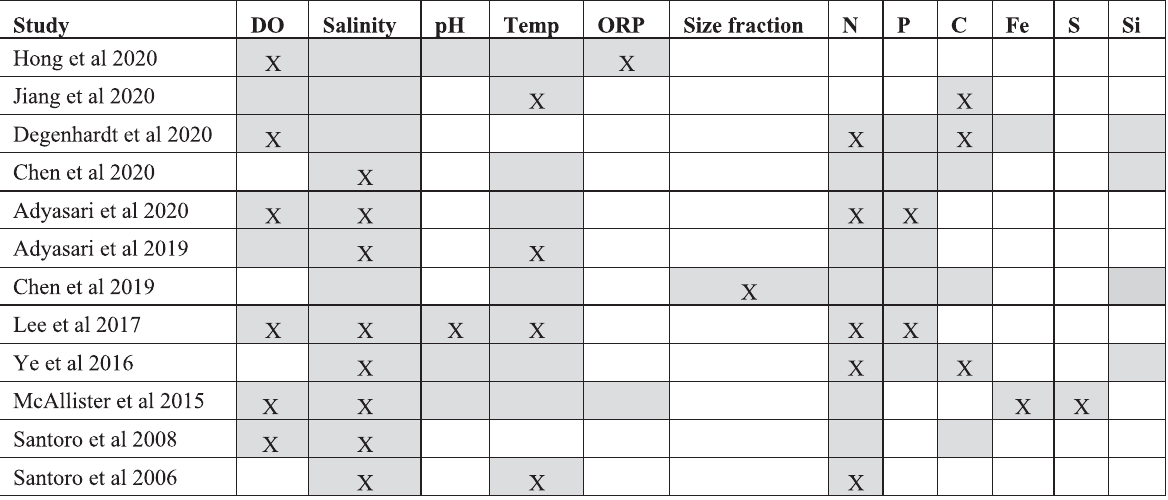
TABLE 3 | Relationships between beach aquifer microbiota and environmental parameters (Empty grey cells refer to measured environmental data, Grey cells with “ X ” indicates authors reported, statistically signi fi cant relationship between microbiome community composition and the environmental parameter; Empty white cells indicate parameters that were not measured by a given study. DO (cid:1) dissolved oxygen, Temp (cid:1) Temperature, ORP (cid:1) Oxidation-Reduction Potential, Size fraction (cid:1) Chen et al. (2019) was the only study that used cellulose acetate fi lters to generate two size fractions: 0.2 – 0.45 µm and > 0.45 µm and study its relationship with the